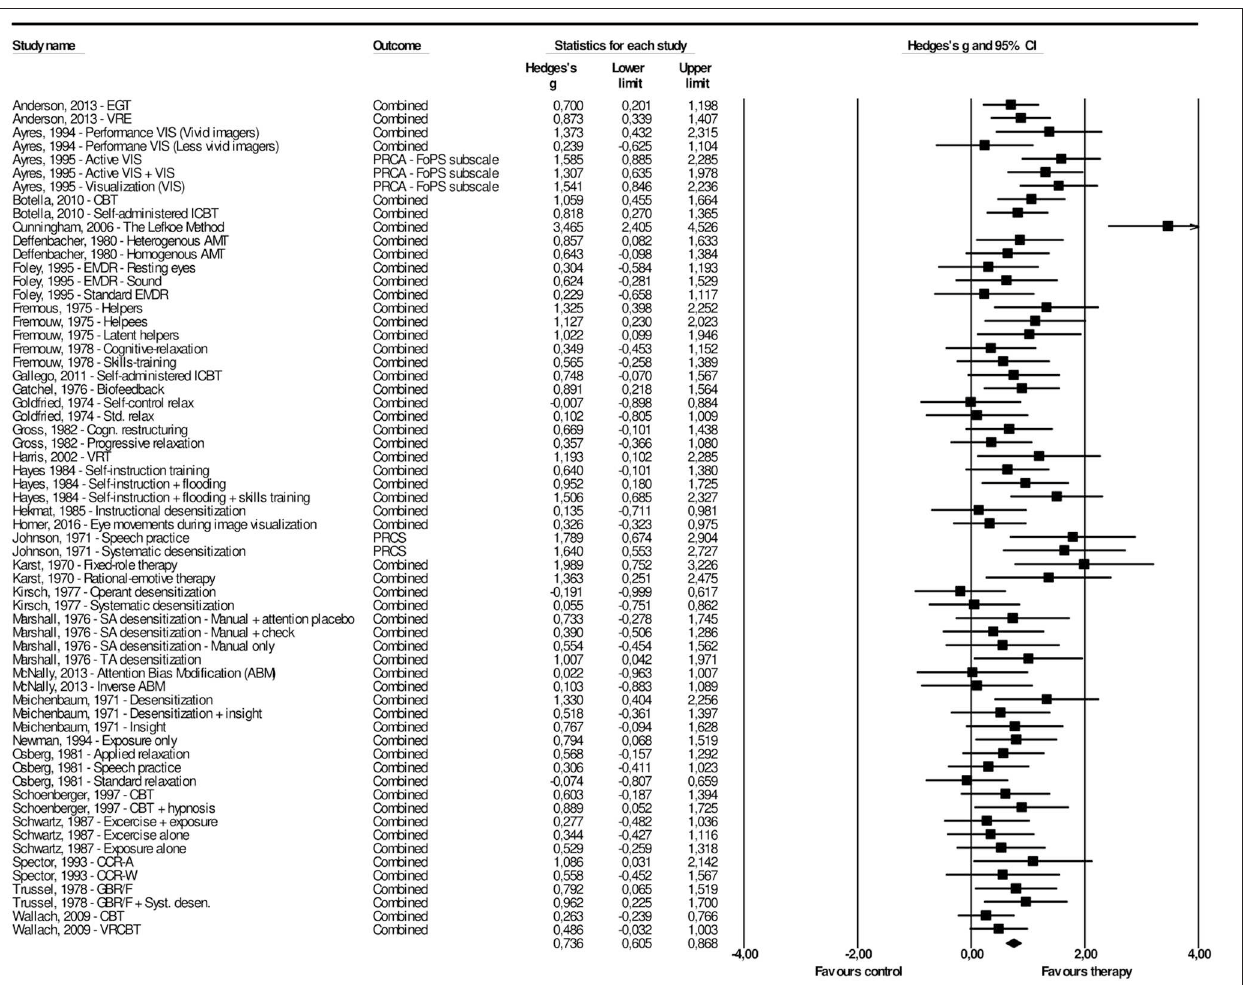
FIGURE 3 | A forest plot of the standardized effect sizes of psychological treatments for fear of public speaking compared with control